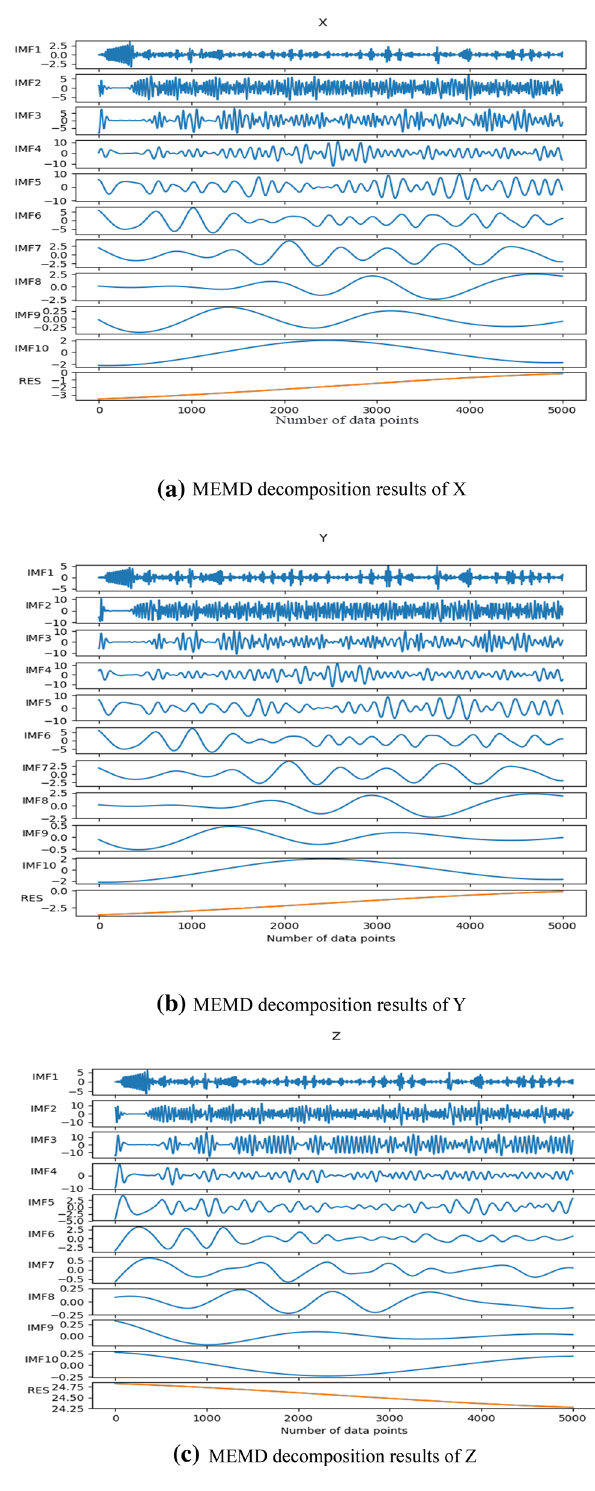
Fig. 3 MEMD results of the Lorenz